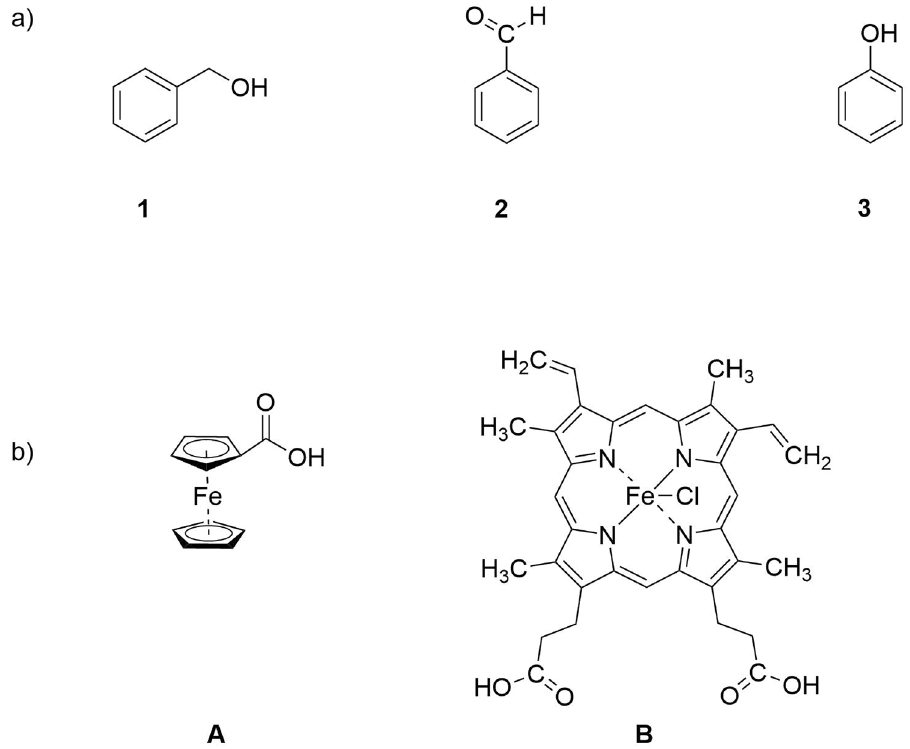
Figure 1. Structures of ( a ) substrates and ( b ) iron